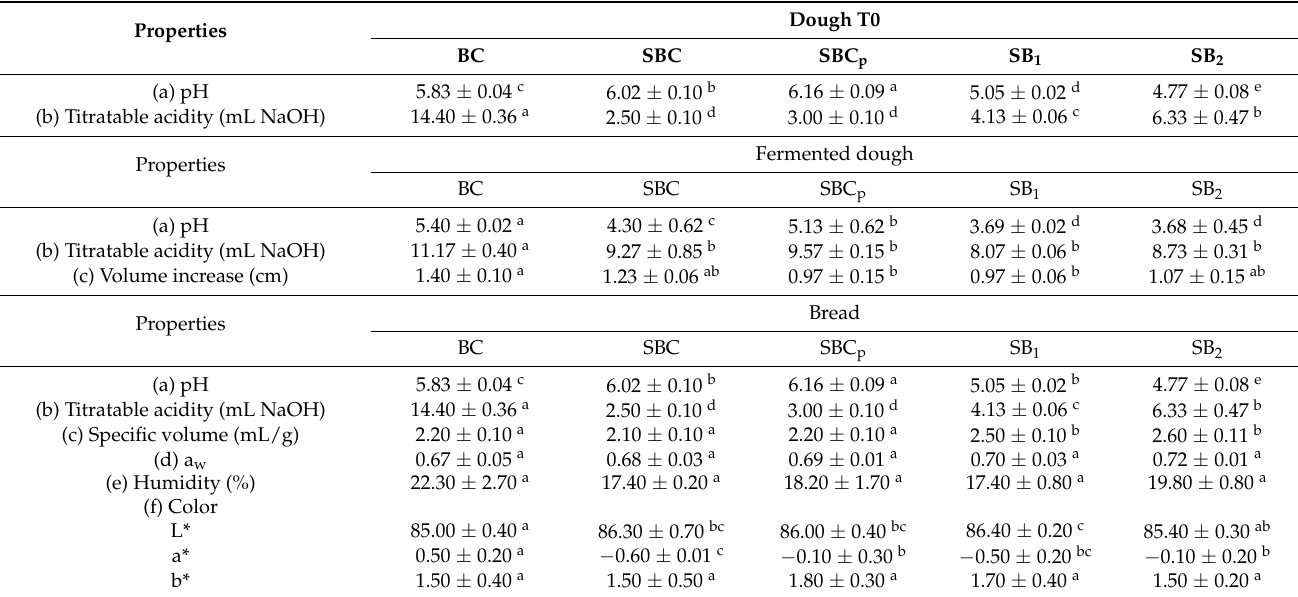
Table 3. Results of properties evaluated in doughs before fermentation (T0), after dough fermentation, and after baked